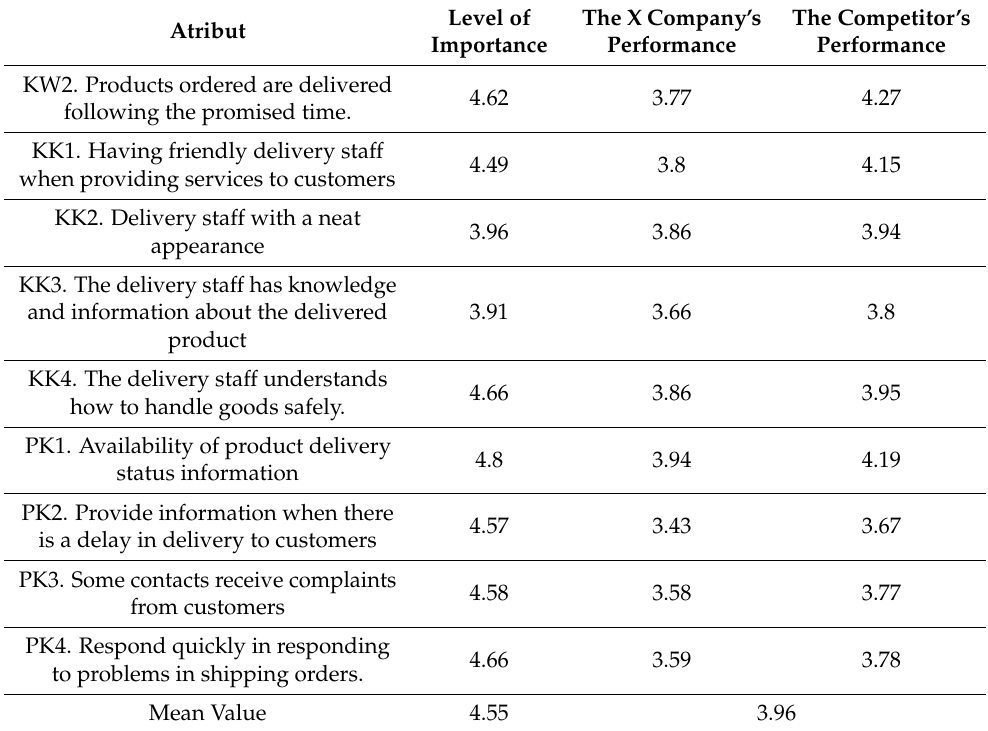
Table 10. Grouping of service attributes using SIPA Modified-Kano. Attributes